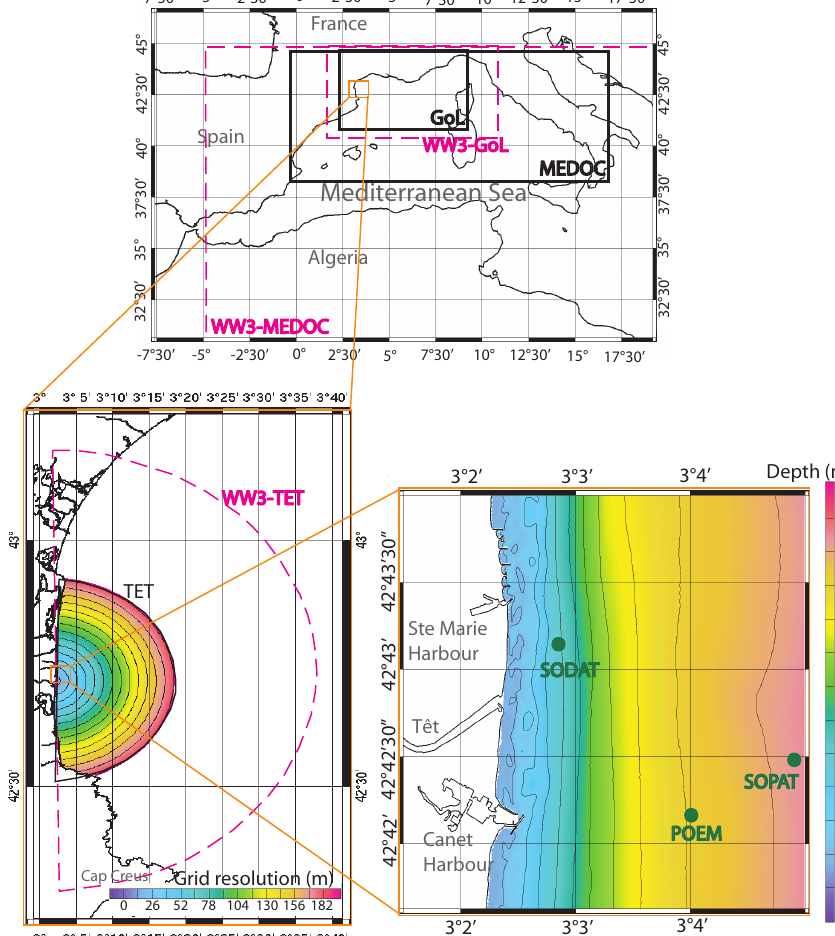
Fig. 7. The three embedded domains used by SYMPHONIE (black frame) and WW3 (dashed pink frame) for the Tˆet inner shelf simulation and positions of the three